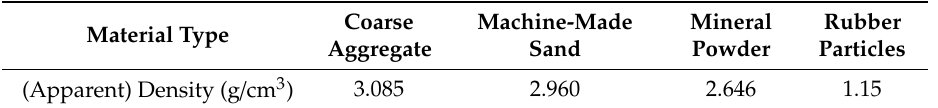
Table 1. The density of raw materials.